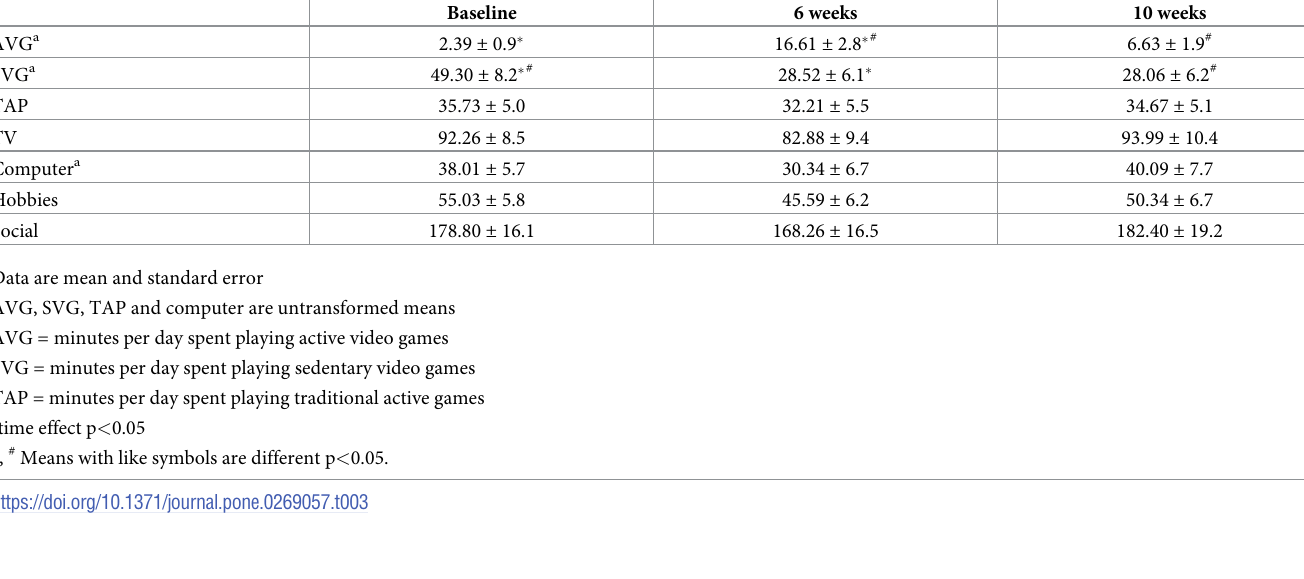
Table 3. Minutes per day spent in active video games, sedentary video games, television, computers, other hobbies and social activities by time point.